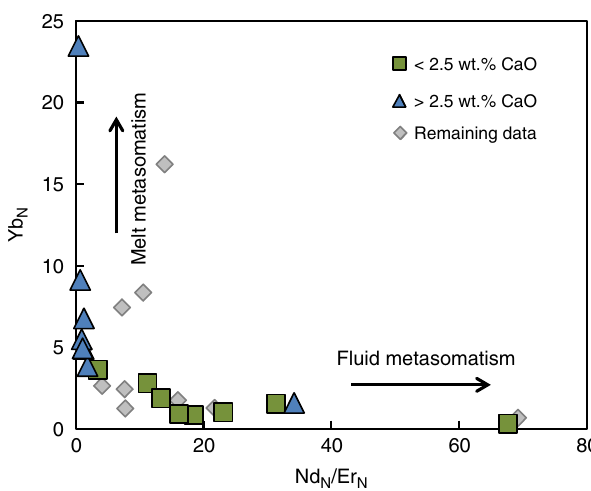
Fig. 5 Chondrite normalised Nd/Er versus Yb for the harzburgitic garnets indicate two types of metasomatism. The low CaO samples with strongly sinusoidal REE N at low HREE document growth in a melt depleted reservoir that was metasomatised by a fl uid. The > 2.5 wt.% CaO samples with modest HREE enrichment suggest melt dominated metasomatism 36